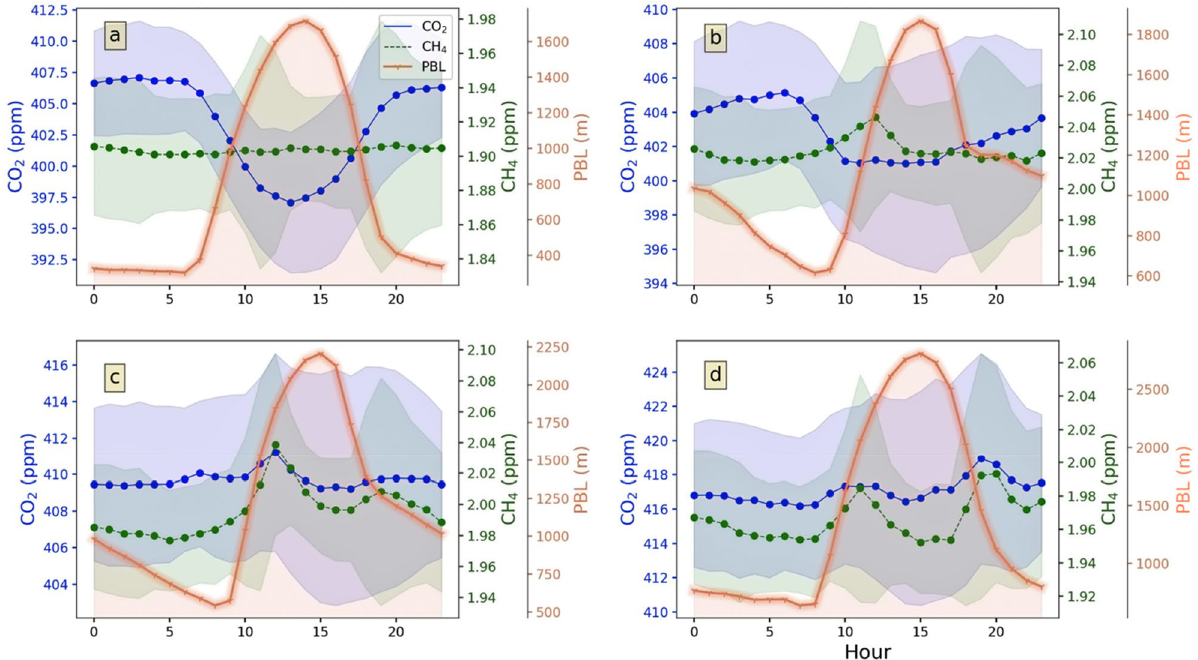
Figure 6. Diurnal variation of seasonal CO 2 , CH 4, and planetary boundary layer height (PBL) during ( a ) monsoon, ( b ) post-monsoon, ( c ) winter, and ( d ) pre-monsoon.